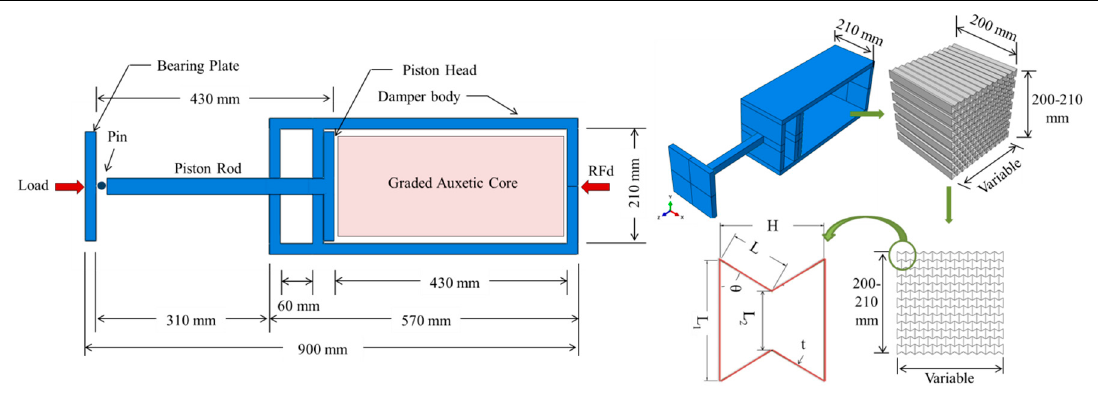
Figure 1. Geometry and components of the proposed uniaxial graded auxetic damper (UGAD).